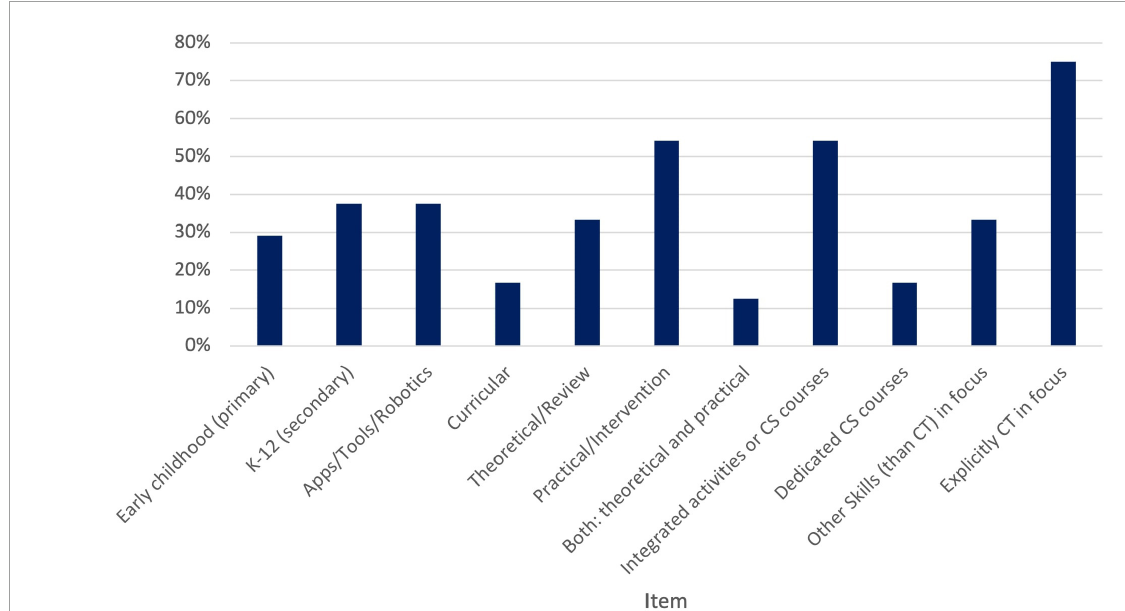
FIGURE2 Percentage of papers by item category.